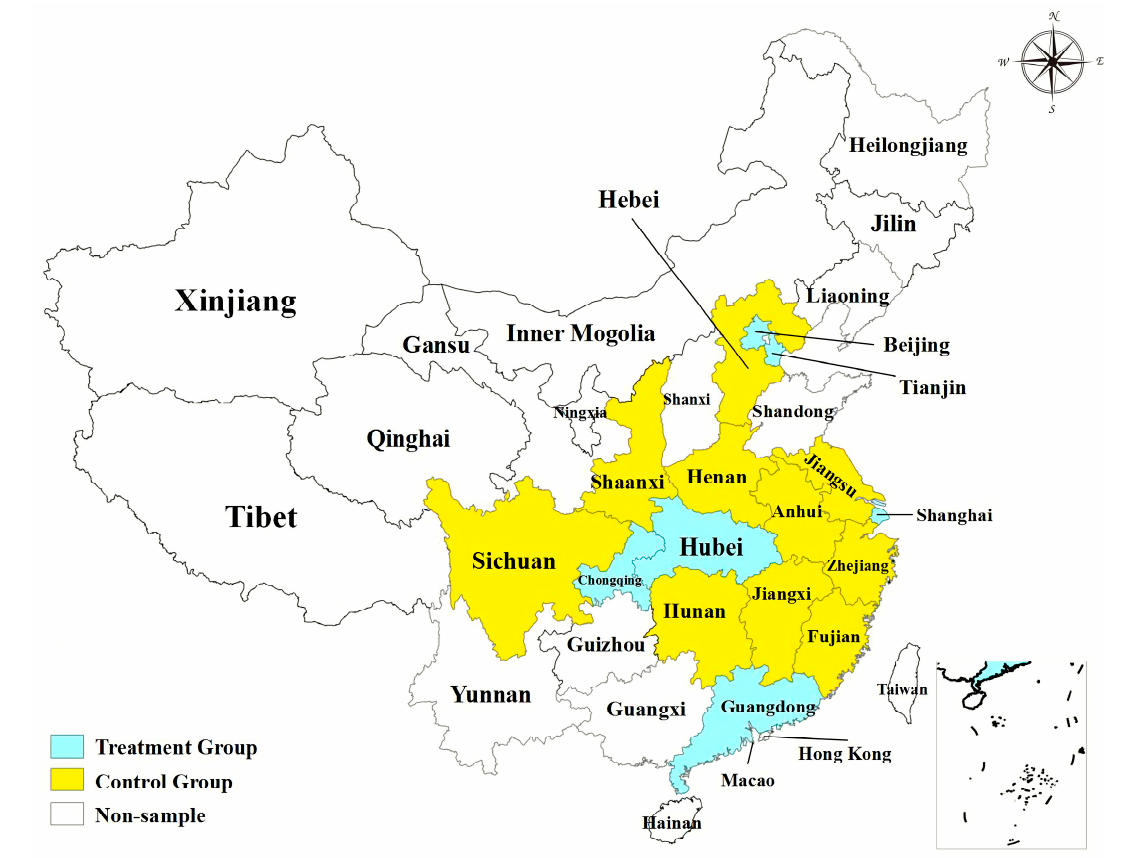
Figure 1. Study areas.